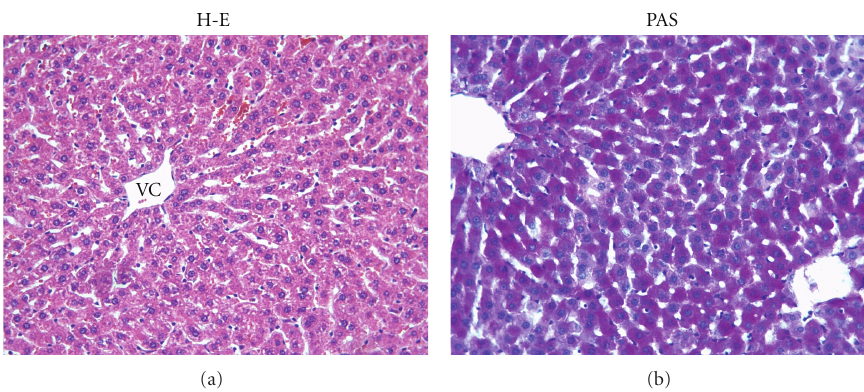
Figure 1: (a) Normal histological appearance of liver in the control group. VC: Vena centralis. (b) The PAS-positive reaction shows a magenta staining where glycogen is present within hepatocytes. X66.